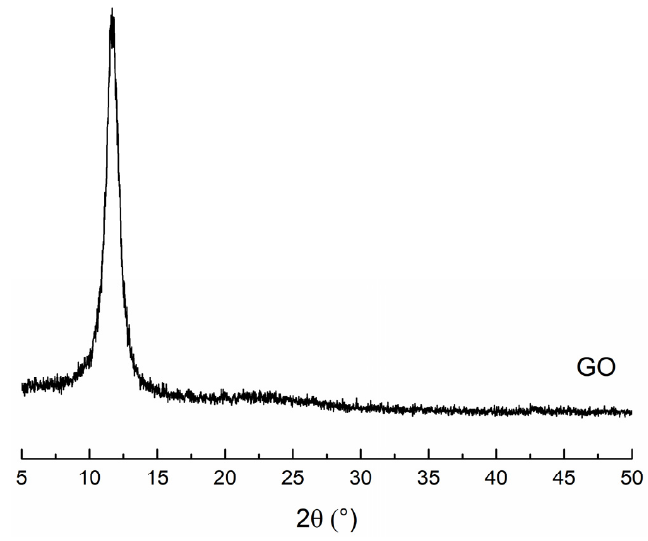
Figure 3. XRD pattern of the synthesized GO.